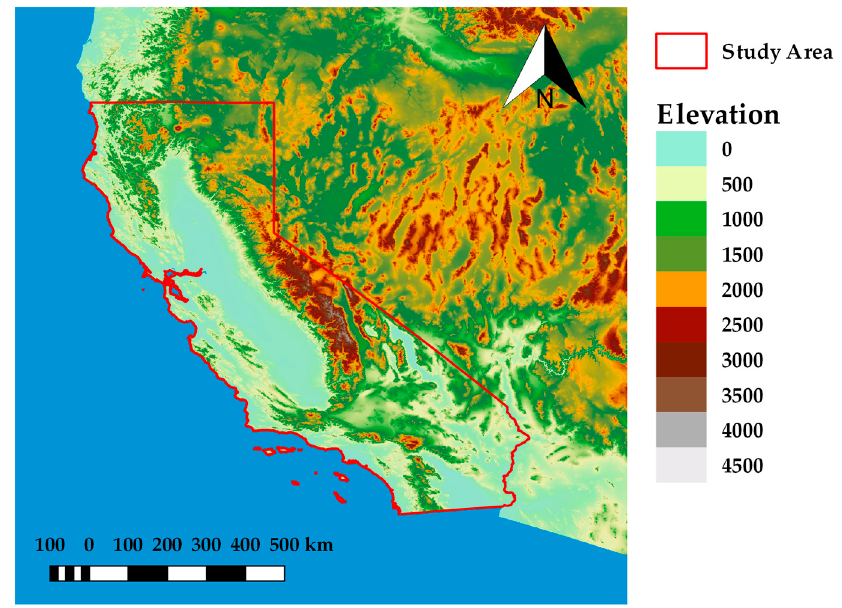
Figure 1. The study area—the state of California, USA.